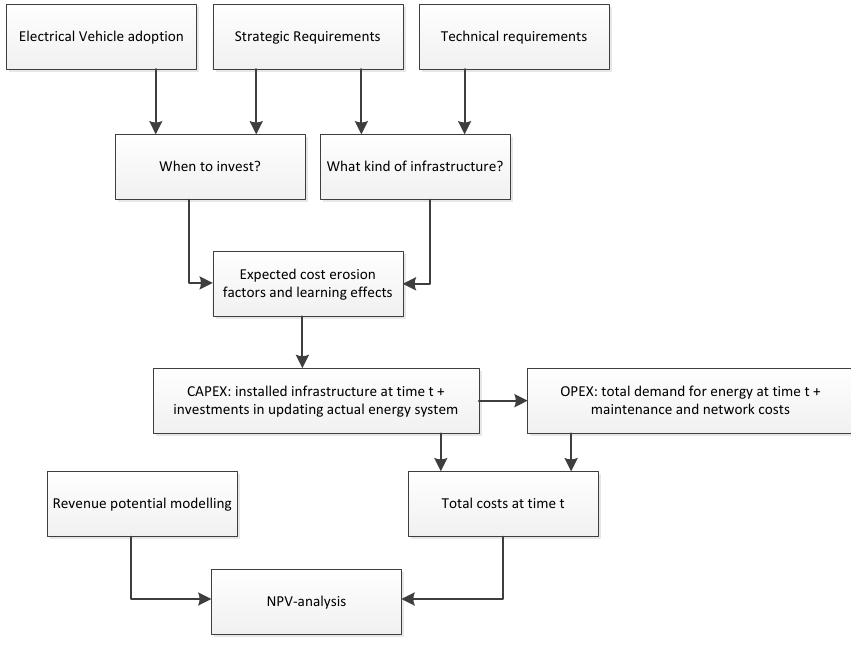
Figure 2. Schematic structure of the